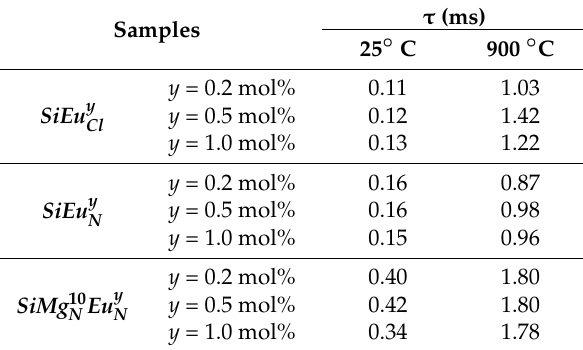
Figure 5. Luminescence decay curves of the 5 D 0 level of Eu 3+ measured at the maximum intensity of the 5 D 0 → 7 F 2 emission band (615 nm) for the different samples ( a ) before and ( b ) after the thermal treatment at 900 °C. Table 2. Average lifetime τ of the 5 D 0 level for the different samples before and after thermal treatment at 900 °C.